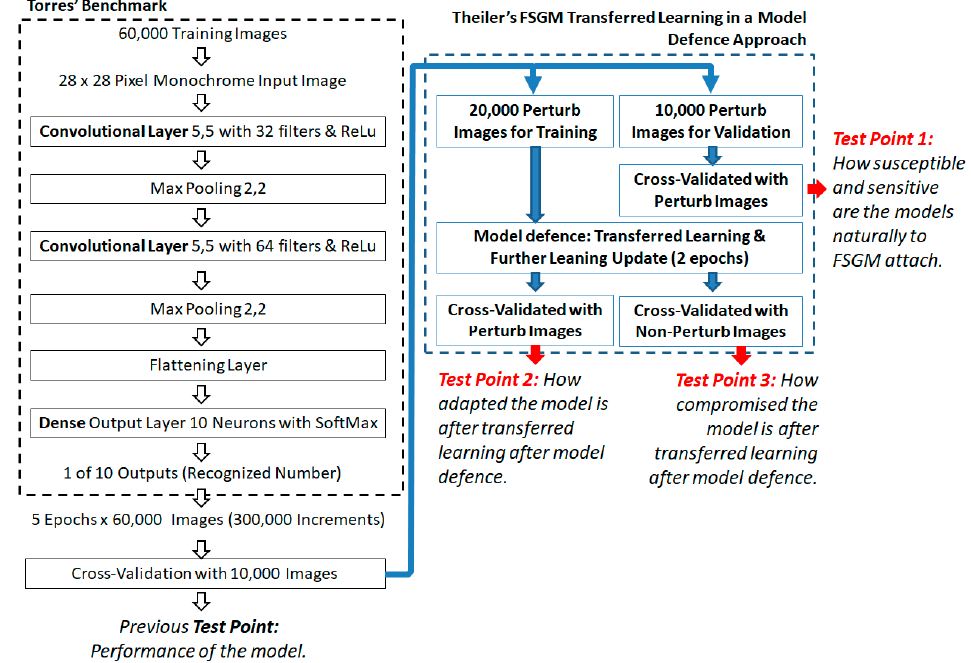
Figure 10. Theiler’s FSGM transferred learning experiment model [36], as added to the Torres benchmark model showing the experiment test points.